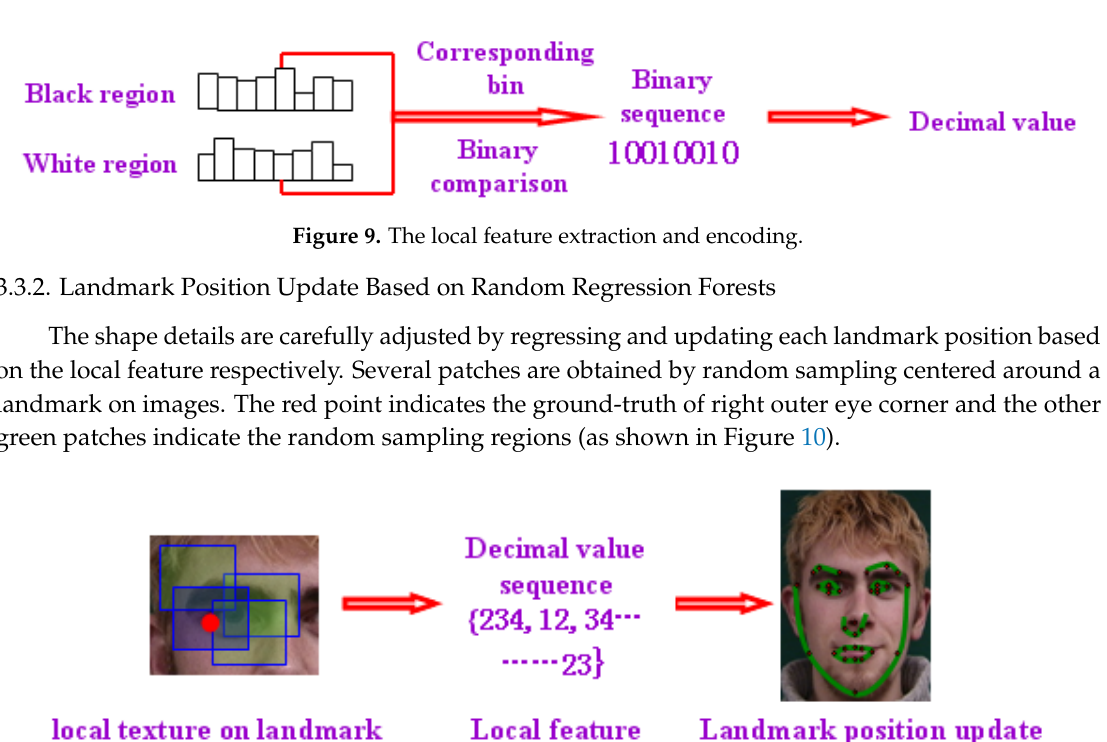
Figure 10. The landmark position update based on local feature regression.